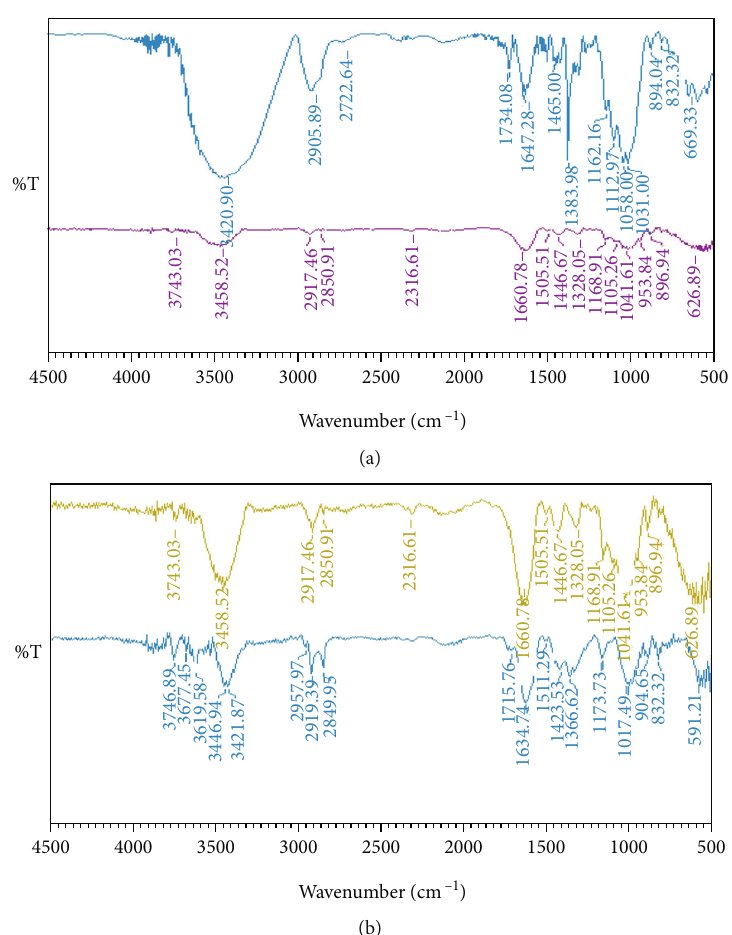
Figure 9: FT-IR spectra to compare (a) KR (blue) vs. NaOH-KR (Purple) and (b) NaOH-KR before (yellow) and after MV adsorption (blue).